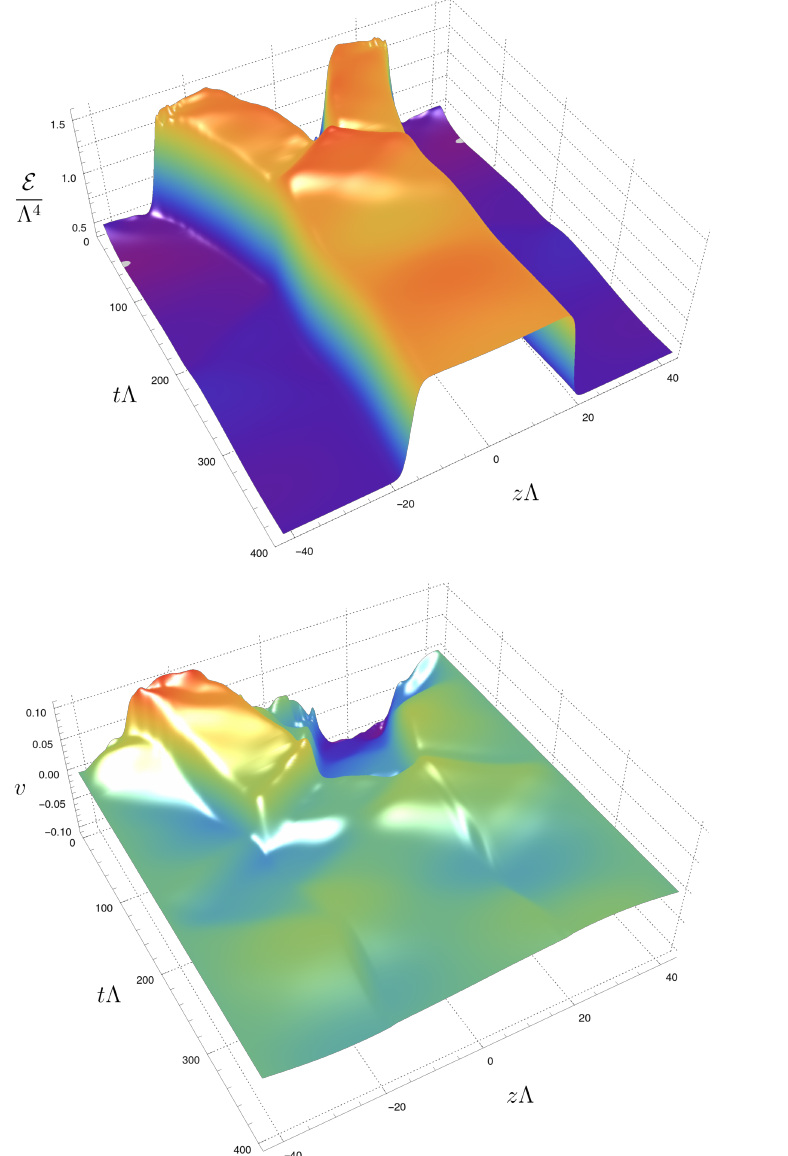
Figure 15 . Evolution of the energy density (top) and of the fluid velocity (bottom) for a simulation with v max = 0 . 11